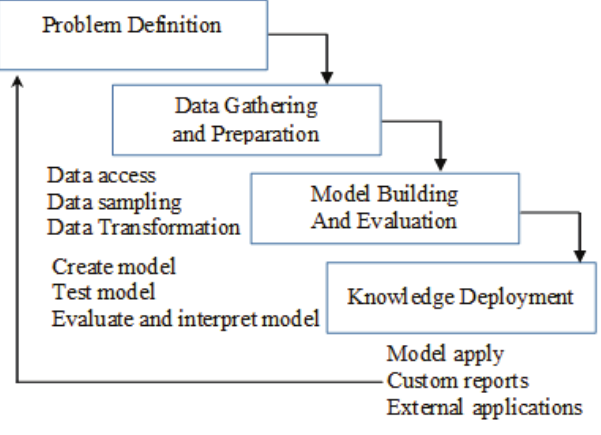
Fig. 1. Model building and evaluation (Kathy L. Taylor,